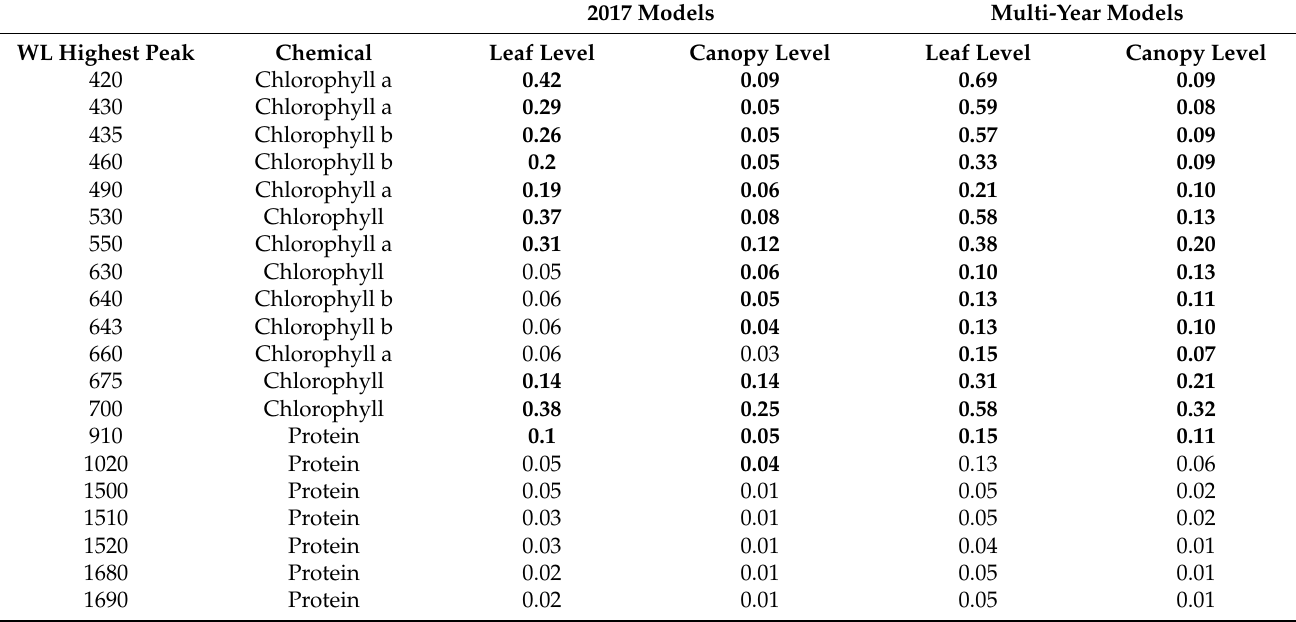
Table A4. Standardized coefficient values of wavelengths associated with chlorophyll a and b combined, chlorophyll a, or chlorophyll b, and protein absorption feature for 2017 and multi-year models at both leaf and canopy levels. Bold values, standardized coefficient value within the top 30 highest standardized coefficients. NA, wavelength removed from the canopy